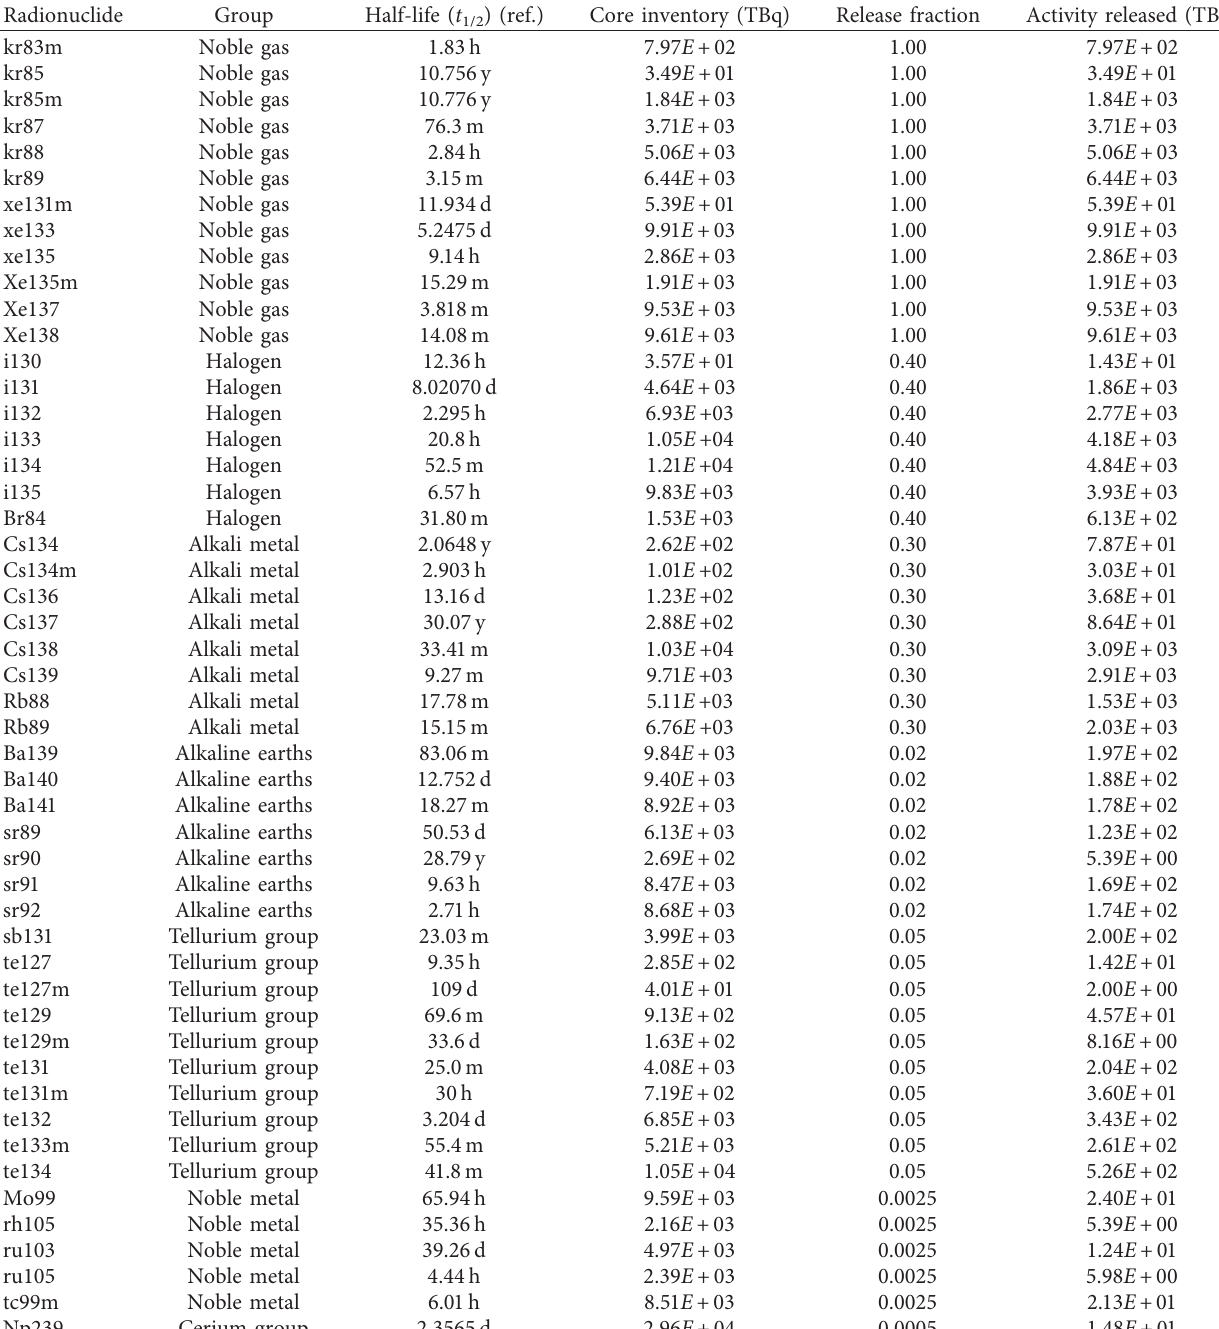
Table 3: Source term selected radionuclide inventory and activity